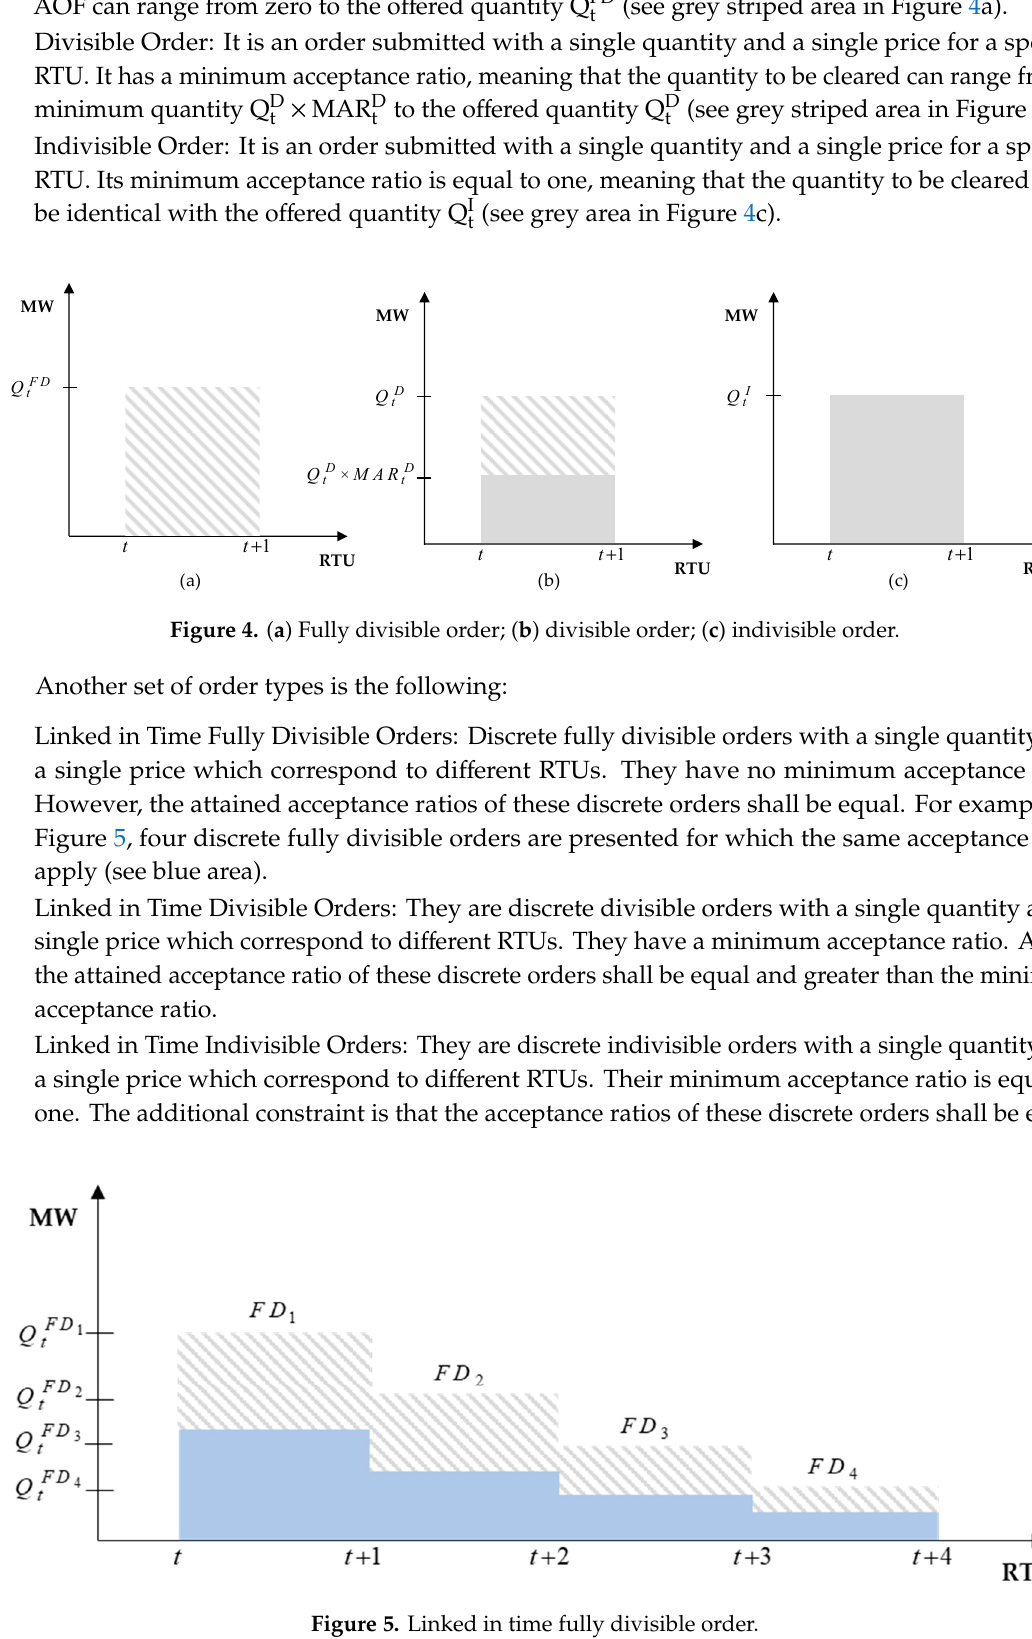
Figure 5. Linked in time fully divisible order.